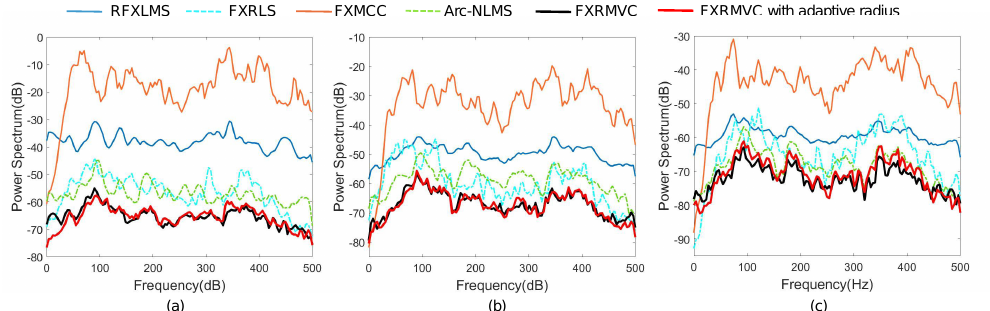
Figure 10. PSD level comparison under mixed Gaussian noise and impulse noise: ( a ) α = 1.2, ( b ) α = 1.4 and ( c ) α =